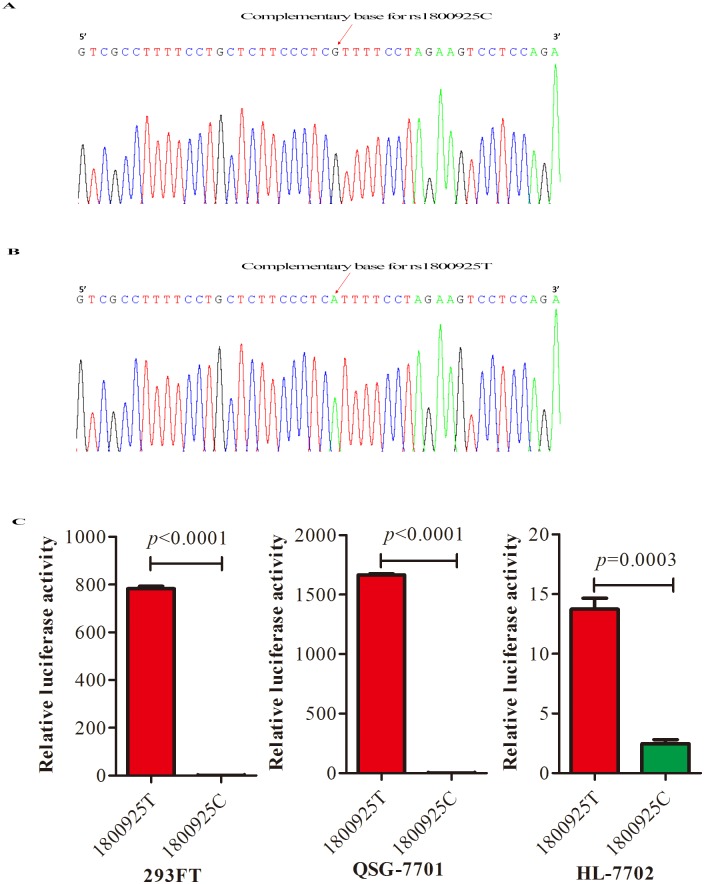
Relative luciferase activity of plasmid construct of PGL4.17-rs1800925T and PGL4.17-rs1800925C in 293FT, QSG-7701 and HL-7702 cell lines.(A) Complementary base sequence of target DNA in plasmid PGL4.17-rs1800925C. (B) Complementary base sequence of target DNA in plasmid PGL4.17-rs1800925T constructed by overlap PCR. (C) Relative luciferase activity of plasmid construct of PGL4.17-rs1800925T and PGL4.17-rs1800925C in 293FT, QSG-7701 and HL-7702 cell lines. (Rs1800925C indicates plasmid PGL4.17-rs1800925C and rs1800925T indicates plasmid PGL4.17-rs1800925T).